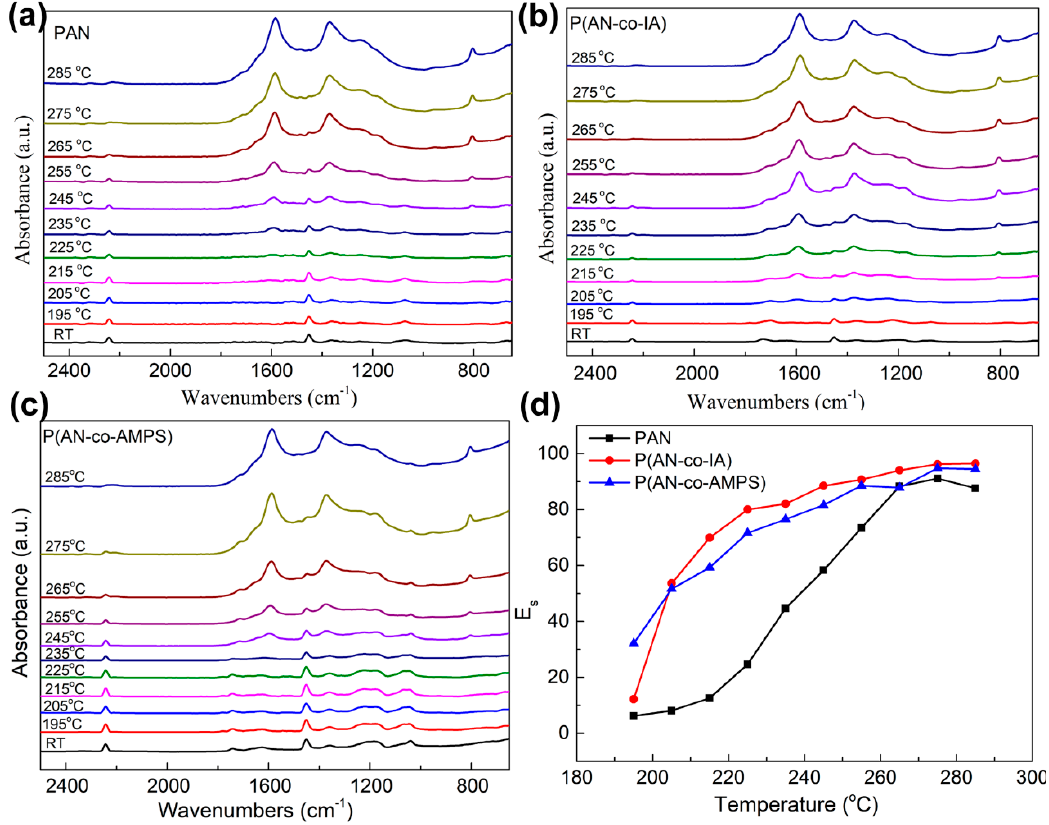
Figure 6. Fourier transform infrared spectroscopy (FTIR) spectra of ( a ) PAN, ( b ) P(AN-co-IA), and ( c ) P(AN-co-AMPS) nanofibers stabilized at different temperatures. ( d ) E s of PAN, P(AN-co-IA), and P(AN-co-AMPS) nanofibers at different temperatures.